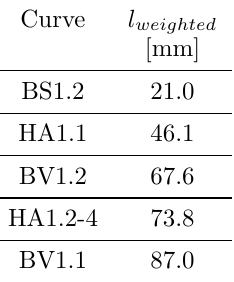
Table 2. Weighted cant deficiencies in curves for all recorded trains (not